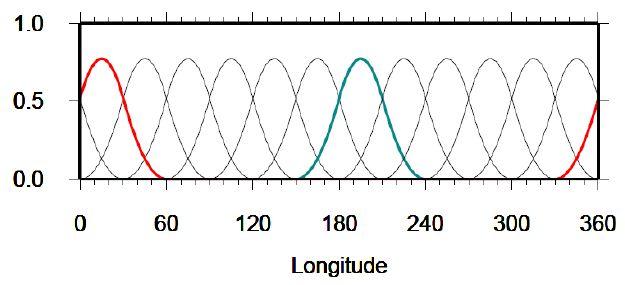
= 3 · 2 2 = 12 trigonometric B-splines e φ J 2 Figure 3. K J 2 ing to Eq. (30) for level J 2 = 2. The blue spline function e φ 2 shift value k 2 = 5 is different from zero only in the subinterval of = 360 ◦ / 4 ≈ 90 ◦ . The red basis function e φ 2 length (cid:49) J 2 the “wrapping-around” effect.